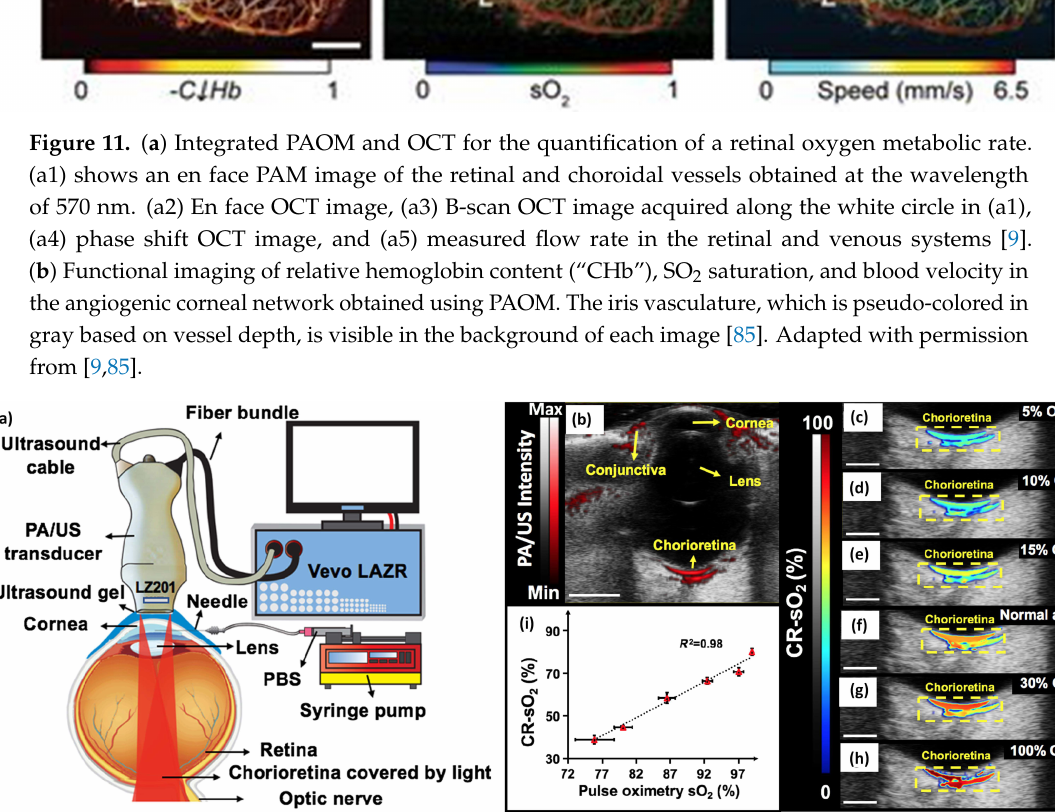
Figure 12. Ultrasound-resolution photoacoustic microscopy imaging for the detection of choroidal and retinal oxygen saturation (CR-SO 2 ). ( a ) The ischemia–reperfusion setup. ( b – h ) Evaluation of the PAOM response to oxygen tensions. ( b ) B-mode photoacoustic/ultrasound image at baseline condition (breathing normal air) including the cornea, conjunctiva, lens, and chorioretina. The image depth is 20 mm. ( c ) The B-mode CR-SO 2 map when the rabbit is given 5% O 2 and 95% N 2 , ( d ) 10% O 2 and 90% N2, ( e ) 15% O 2 and 85% N 2 , ( f ) normal air, ( g ) 30% O 2 and 70% N 2 , and ( h ) 100% O 2 . ( i ) PAOM-CR-SO 2 measurements [41]. CR: chorioretinal vessels. Adapted with permission from ref.